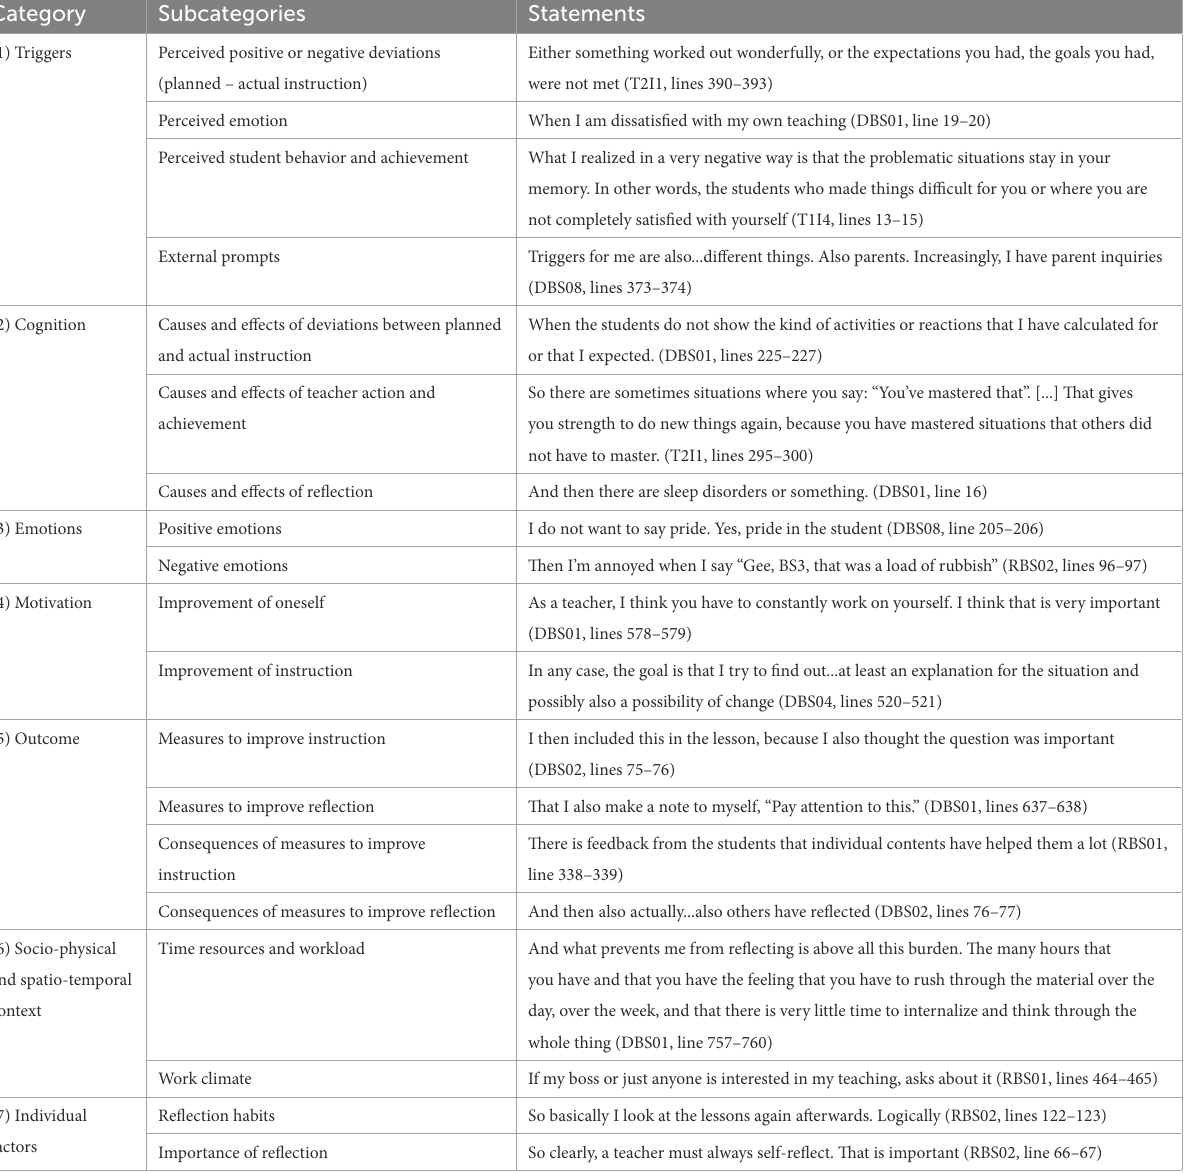
TABLE 2 Original different things. Also parents. Increasingly, I have views on